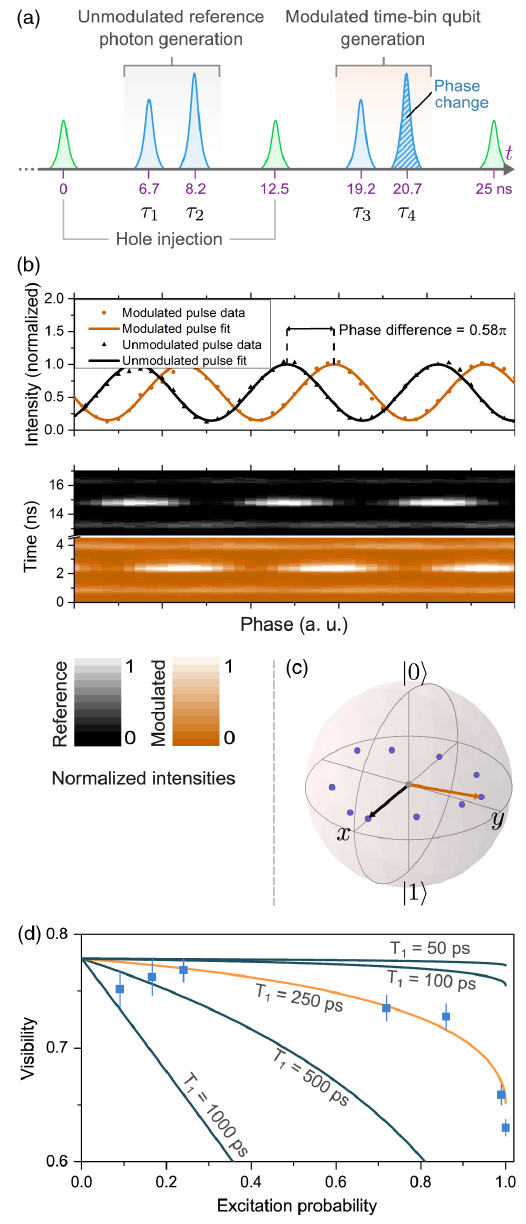
FIG. 2. (a) An illustration of the pulse sequence used to demonstrate phase control over a time-bin qubit. (b) The ex- tracted interference fringes for reference (black) and phase modulated (orange) photons. We show the time-resolved plots of the interference between neighboring time bins for the two sequences that allow us to extract the interference fringes and the probabilities of measuring the photon in each time bin. (c) The recorded time-bin qubits mapped onto the Bloch sphere (blue points). The black and orange vectors represent the states generated by reference and example modulated pulse sequences, respectively. (d) The measured interference visibility as a func- tion of photon generation probability (blue data points) and the calculated expected interference visibility for several different radiative decay times